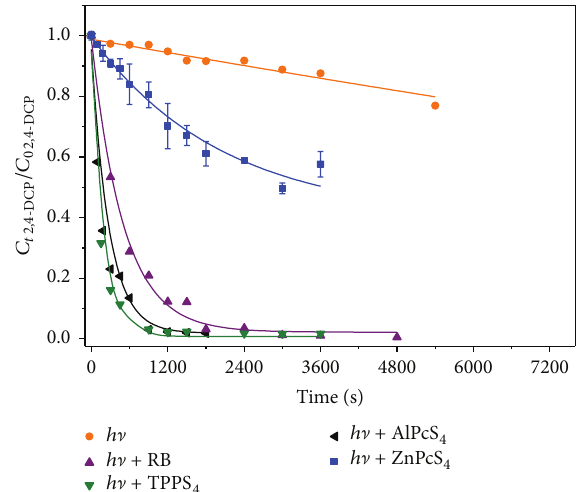
Figure 3: The dependence of 2,4-DCP relative concentrations decay on the type of used photosensitizer ( 𝐶 02,4 𝐶 × 10 −5 M, pH = 10.8, oxygen bubbling, and xenon lamp 0 sens . = 2 irradiation).